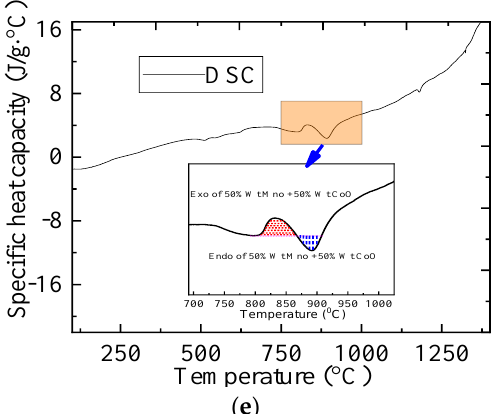
Figure 3. The thermal performance of mixed and pure oxide during the experiment at 30 mL Ar/min and 20 mL O 2 /min gas flow rates subjected to heating from 30 to 1400 °C at 30 °C/min heating rate and cooling to 800 °C for two-cyclic redox reactions: ( a ) The oxygen uptake ratio in both cyclic redox reactions; ( b ) the enthalpy for mixed all oxides under test; ( c ) the conversion performance of all oxides under state ( d ) conversion performance for all oxides under the test with time; ( e ) specific heat capacity for 50 wt.% MnO + 50 wt.% CoO with temperature. Table 1. Physical properties during charging from 25 to 1400 °C with rounding to three digit [55]. Material Onset Enthalpy (J/g) Phase Changing Conversion Material Temperature Temperature ( ◦ C)Crystallization Melting Reduction ( ◦ C) 25 wt.% MnO + 75 wt.% CoO 50 wt.% MnO + 50 wt.% CoO 75 wt.% MnO + 25 wt.% CoO 25 wt.% MnO + 75 wt.% CoO